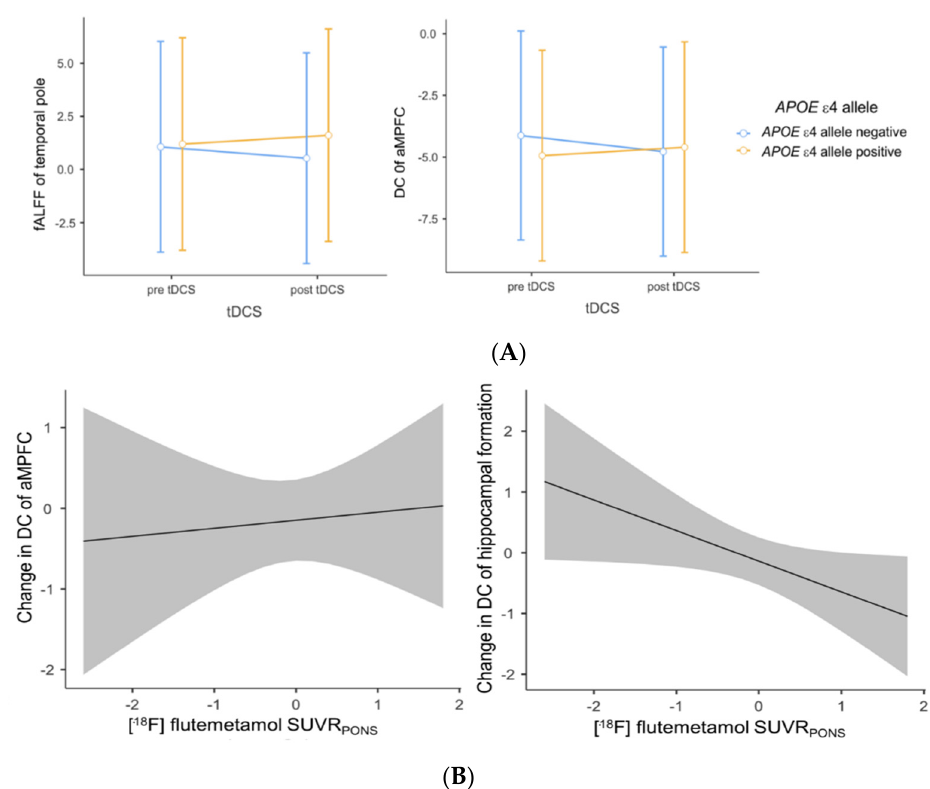
Figure 1. ( A ) Impact of interaction between tDCS and APOE ε 4 allele on fALFF and DC. ( B ) Associations between [ 18 F] flutemetamol SUVR PONS and changes in amplitude of DC. Repeated-measures analysis of variance was used to predict the impact of interaction ( A ) between tDCS and APOE ε 4 allele on fALFF and DC, with adjustment for age, sex, and education years ( p = 0.036, partial η 2 = 0.164; p = 0.056, partial η 2 = 0.138, respectively). ( B ) Multiple linear regression analysis was used to evaluate the associations between [ 18 F] flutemetamol SUVR PONS and changes in DC before and after tDCS, with adjustment for age, sex, and education years ( p = 0.075, R 2 = 0.240; p = 0.042, R 2 = 0.182). Each variable was z-transformed using the mean and standard deviation. Changes in fALFF and DC were defined as post-tDCS z-transformed values minus pre-tDCS z-transformed values. Abbreviations: tDCS, transcranial direct current stimulation; fALFF, fractional amplitude of low-frequency fluctuation; DC, degree centrality; SUVR, standardized uptake value ratio; A β , amyloid beta; aMPFC, anterior medial prefrontal cortex.